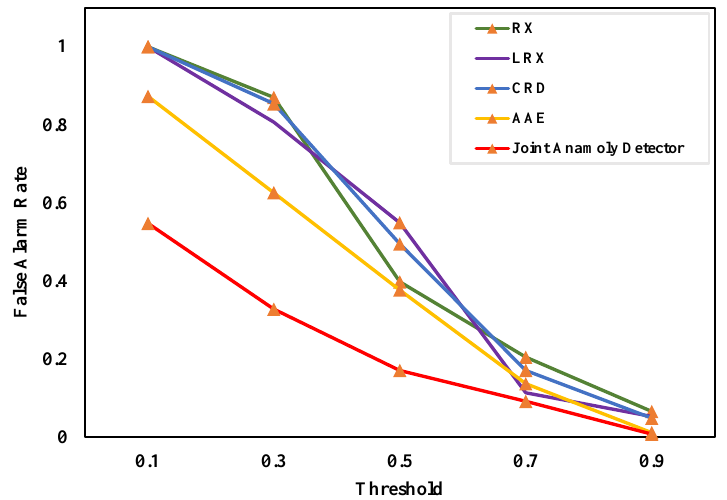
Figure 10. The FPR of different anomaly detection methods with some certain